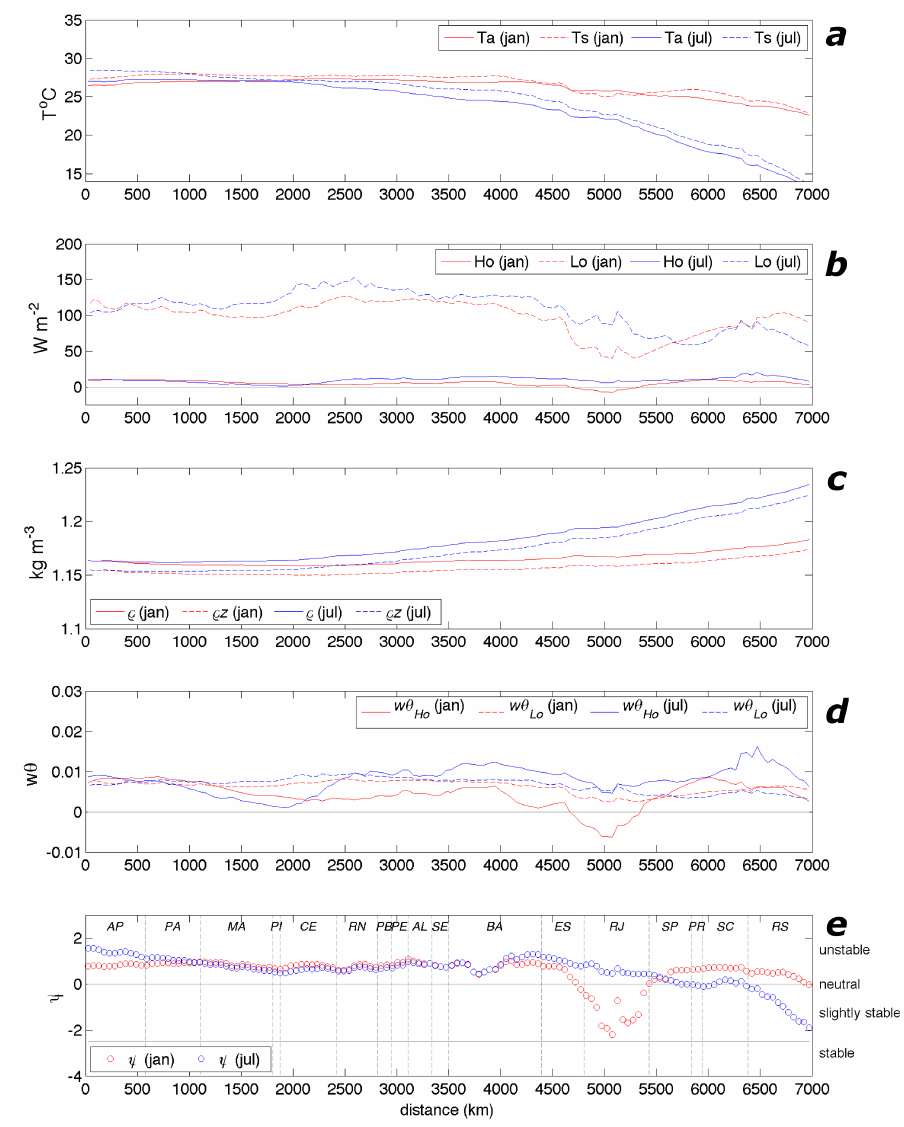
Figure 3. Along-coast variability of thermodynamic fields. Here the x-axis represents the distance (km) along the Brazilian coast, from its northern limit at Amapá (AP, left) to its southern end at Rio Grande do Sul (RS, right). ( a ) air ( T a ) and sea surface ( T s ) temperatures. ( b ) sensible ( H o ) and latent ( L o ) heat fluxes. ( c ) surface ( ρ ) and hub-height ( ρ z ) air densities. ( d ) surface virtual temperature fluxes due to sensible ( w θ Ho ) and latent heats ( w θ Lo ). ( e ) dimensionless stability function ψ . Colors refer to January (red) and July (blue). All quantities were averaged along the sectors shown in Figure 1 up to depths of 100 m. Coastal states’ labels are shown in the bottom